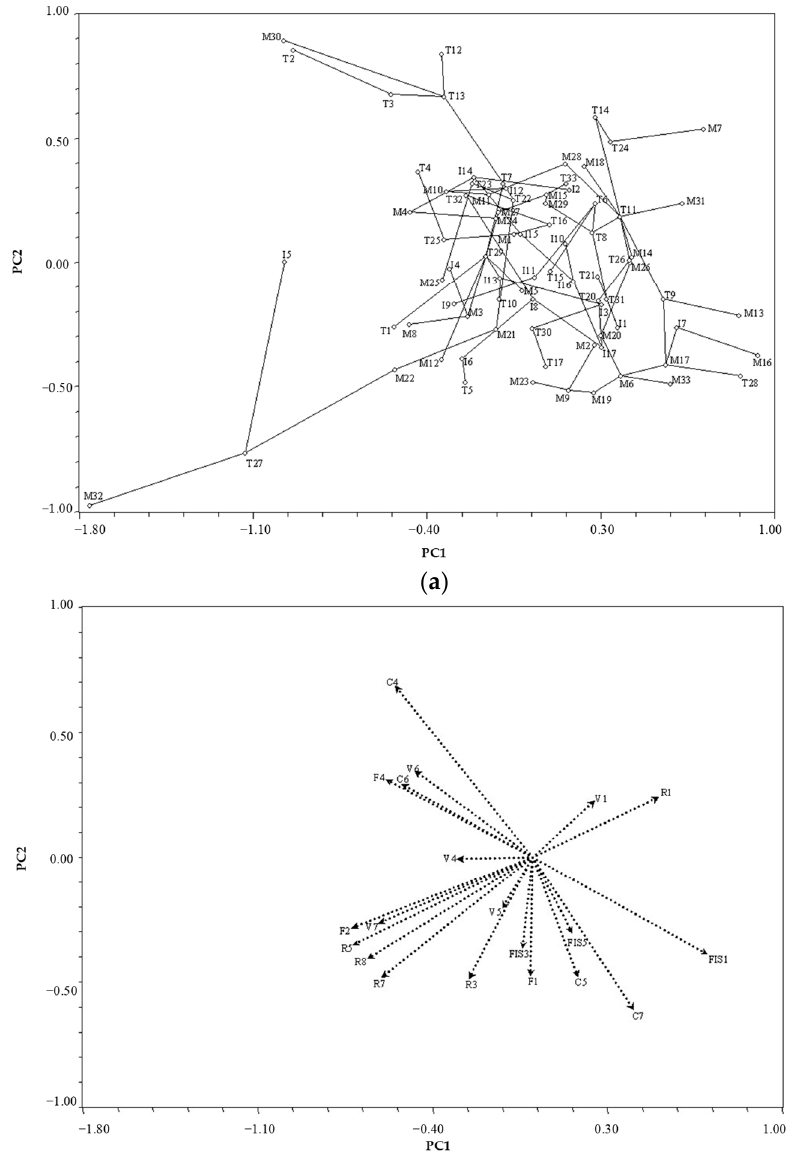
Figure 2. ( a ) PC1 and PC2 projection plots of the 81 tropical species (as listed in Tables 1 and 3) based on 20 anatomical and physical wood characteristics (coded in Table 2), overlapped by the MST method (similarity coefficient of 0.87). ( b ) The indication of the correlation degree between the variables based on the position of the